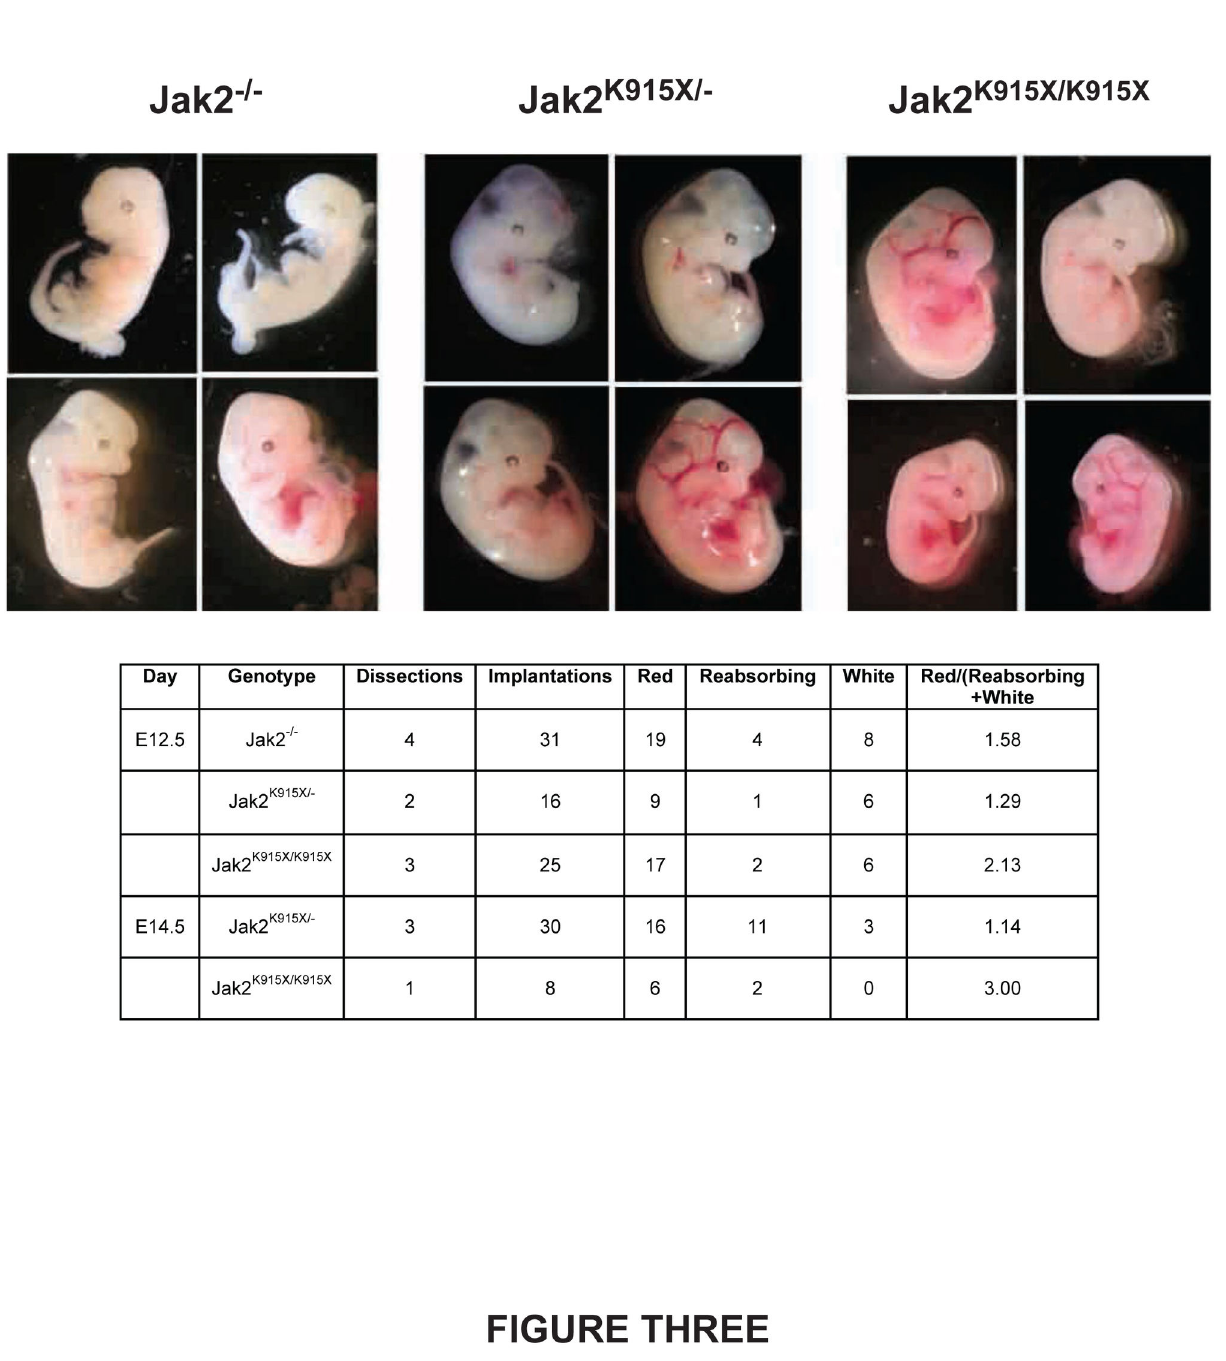
Figure 3. The K915X mutation in Jak2 enhances viability of mouse embryos. Embryos from timed matings were sacrificed at E12.5-E14.5. Representative embryos from E12.5 are shown. A summary of the results is provided in tabular format. doi: